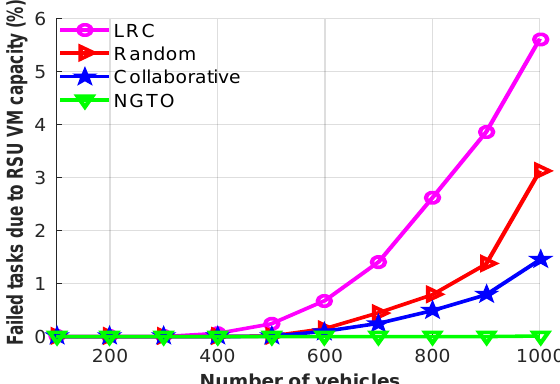
Figure 5. The average failed task rates due to the RSU VM